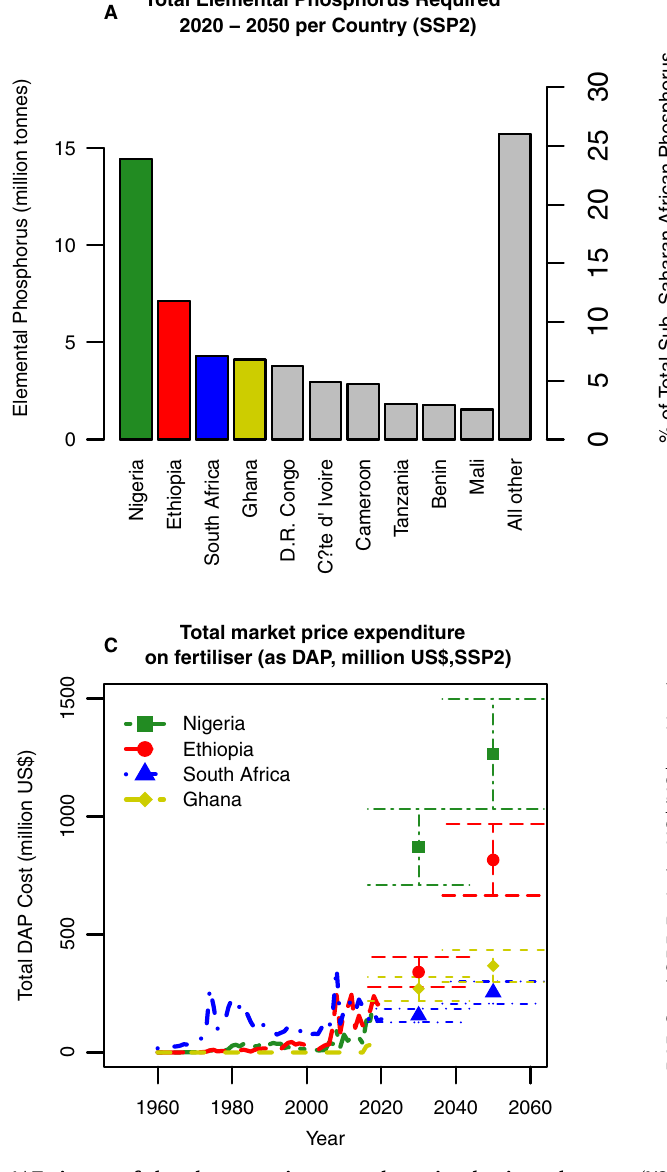
(USD $/USD $, unitless) from 1950 to 2050 in Nigeria, Ethiopia, South Africa and Ghana. Phosphorus, phosphate rock and DAP data are calculated by this project, historic DAP price and GDP are provided by the World Bank 21,59 and projected GDP 51 . For fi gures C and D error bars represent 1 standard deviation propagated from the standard deviationofthe priceor expenditure, respectively, forthe years 2010 – 2020.